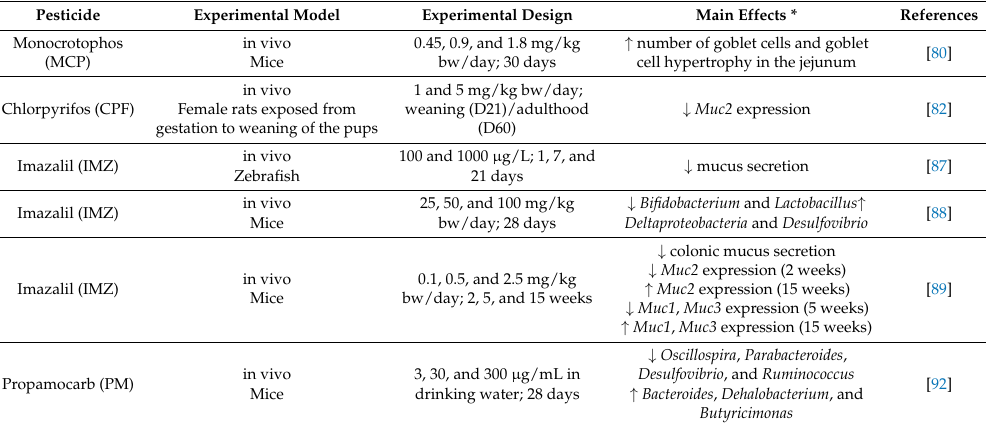
Table 2. Effects of pesticides on mucus and mucophilic bacteria in the